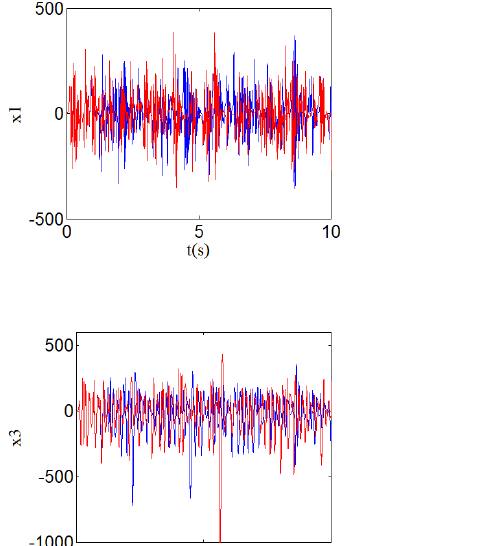
Figure 8. The hyperchaotic system initial value sensitivity with parameters